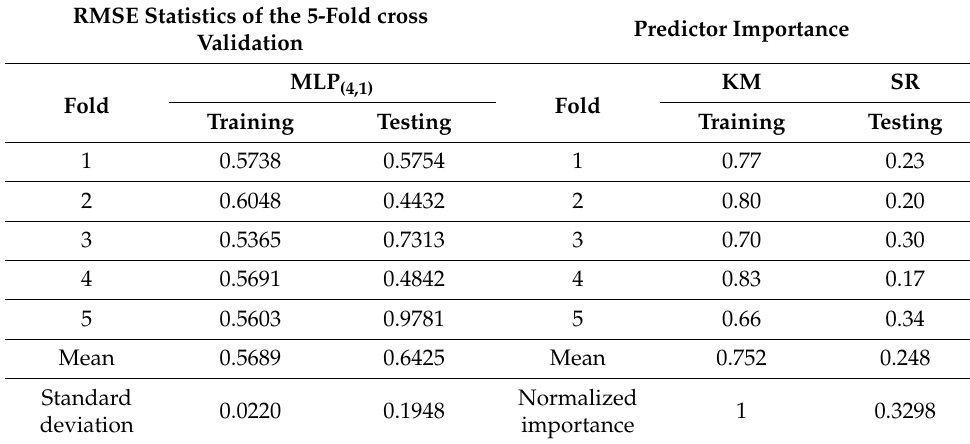
Predictor Importance